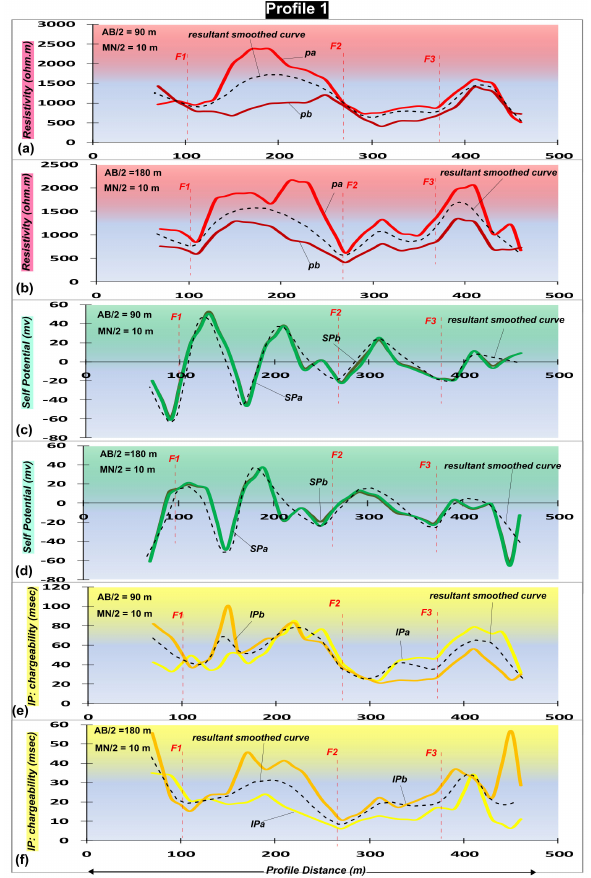
Figure 9. Graphical plots of Joint Profile Method (cross-sectional) along profile 1 for ( a , b ) resistivity ( c , d ) self potential and ( e , f ) induced